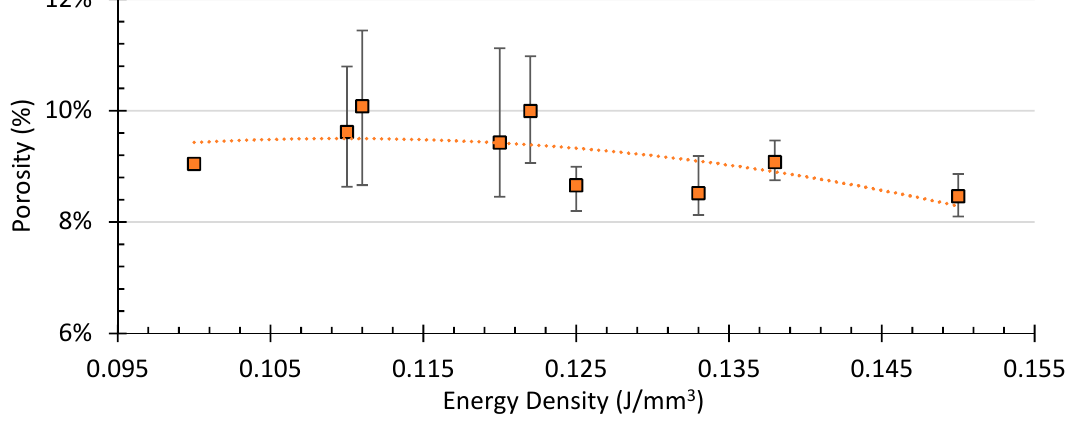
Figure 9. Porosity in the samples as a function of energy density and a polynomial trend-line.